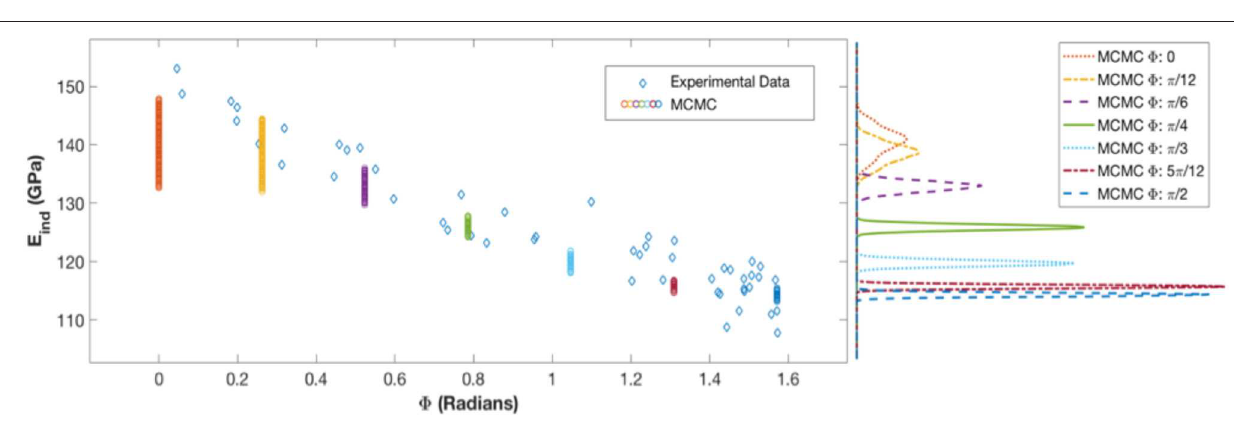
to truncation levels Q = 2, L = 4 using a training set